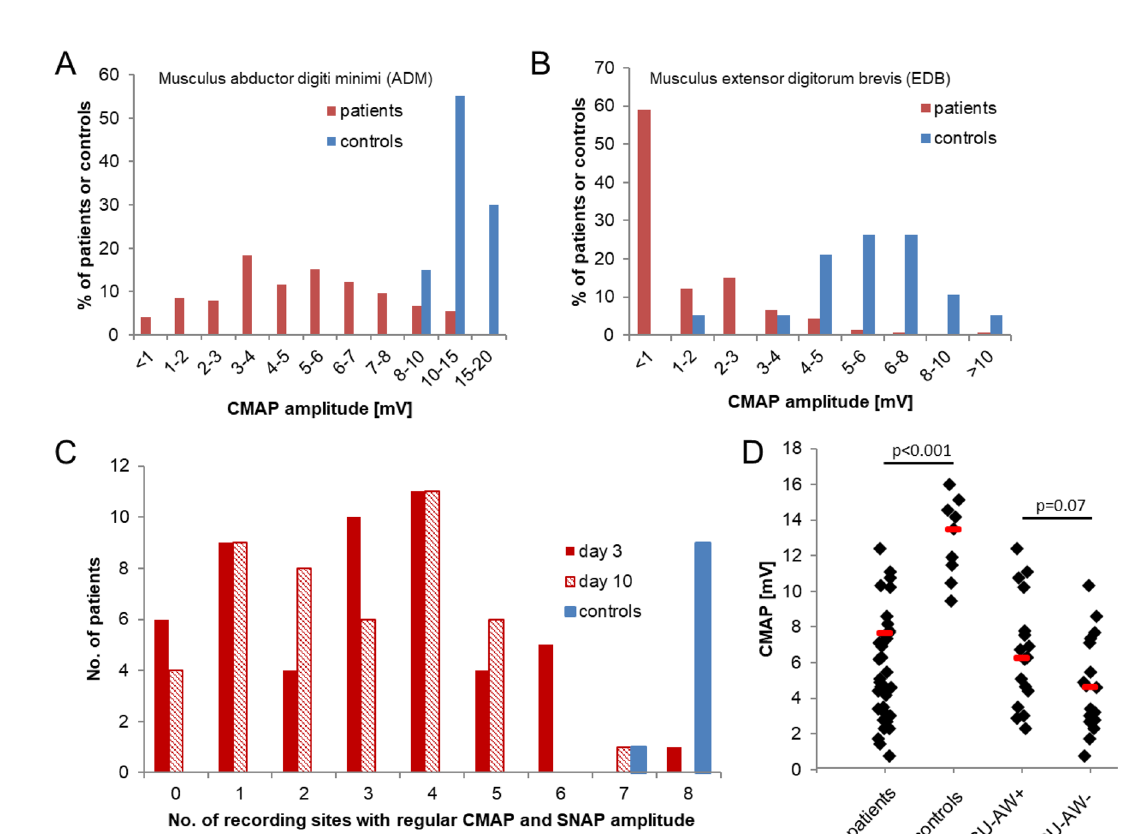
Figure 1. Electrophysiological parameters of neuromuscular function of patients and controls. ( A ) Distribution of CMAP-amplitudes recorded from the upper extremity (ADM, bilateral) among patients and controls. ( B ) Distribution of CMAP-amplitudes recorded from the lower extremity (EDM, bilateral). ( C ) The number of recording sites giving SNAPs or CMAPs of regular amplitude was summed up for each patient. The distribution of patients or controls according to their individual sum score is displayed. For patients, separate distributions are shown based upon the measurements done at the 3rd and on the 10th day of their critical illness. ( D ) ADM- CMAPs recorded at day 10 and averaged from both sides in patients with and w/o ICU-AW. Red bars depict mean values. Differences between all patients and all healthy controls and differences between ICUAW + /− subjects were separately tested with t-tests for independent